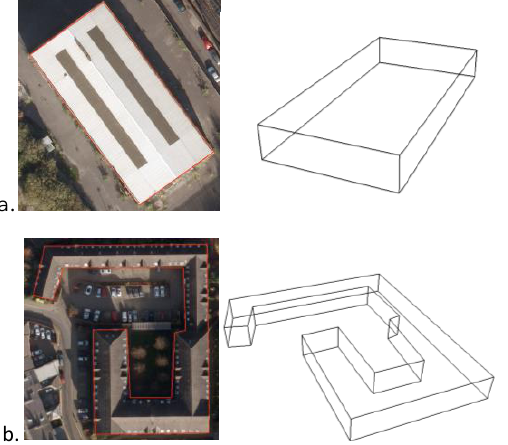
Figure 6. Results of LoD1 reconstruction for (a) a gabled roof and (b) a more complex roof